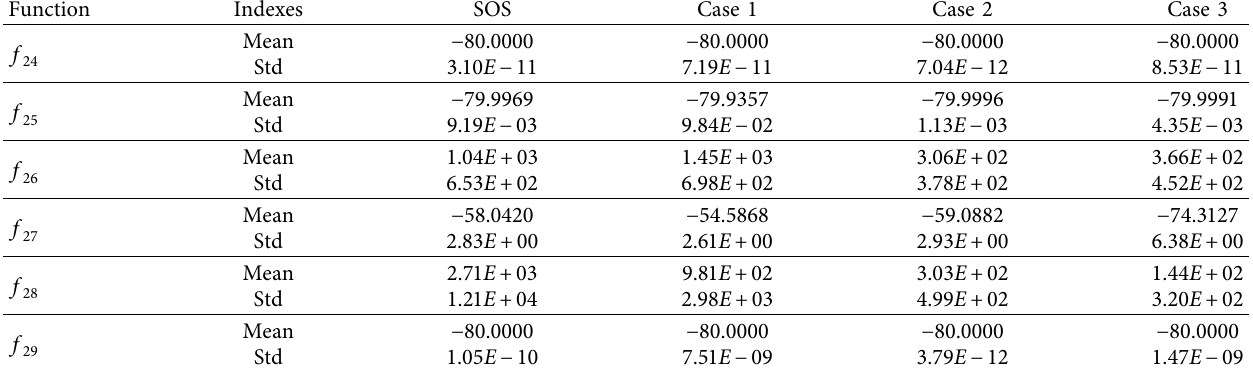
Table 9: Efect of the three cases on the SOS for shifted and biased unimodal functions. Function